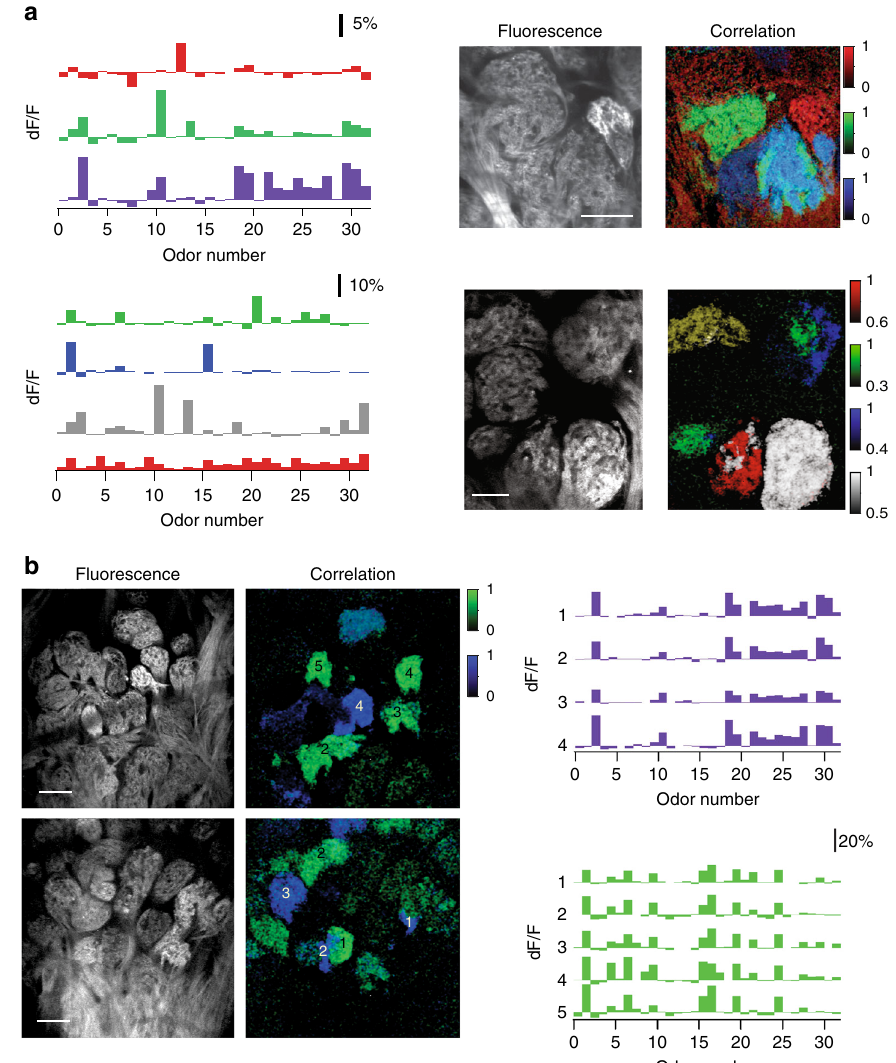
Fig. 3 Local functional glomerular duplications in OMP – / – mice. a (Left) Example average odor response spectra of PCA-identi fi ed functional clusters corresponding to glomerular microdomains from two different fi elds of view (top vs. bottom). (Right) Corresponding resting fl uorescence and overlay of correlograms. Note the presence of functionally homogeneous and heterogeneous glomeruli adjacent to each other. For example, in the lower panel, six anatomically identi fi able glomeruli are discernable. The correlograms (Right) indicate that green microdomains are shared between two close-by anatomical glomeruli. White and red microdomains mix within one anatomical glomerulus. The white cluster is also present as a spatial-functional homogeneous adjacent glomerulus. Color scale units are correlation coef fi cient. Scale bar, 50 μ m. b Two partially overlapping example fi elds of view in one OMP – / – mouse. (Left) Resting glomerular fl uorescence. (Center) Correlograms: colors correspond to functionally matched glomeruli or subglomerular microdomains. (Right) Odor response spectra for the green and blue glomeruli. Numbers correspond to the location of the functionally similar glomeruli in the sampled fi elds of view. Color scale units are correlation coef fi cient. Scale bar, 80 μ